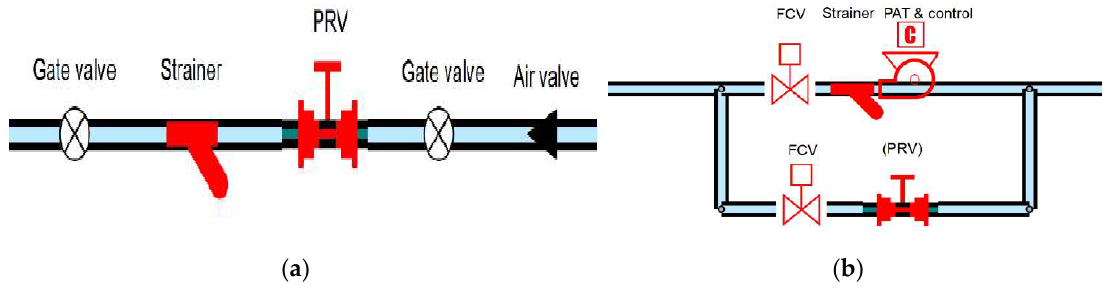
Figure 5. Installation scheme of a pressure reducing valve (PRV) ( a ) and a pump as turbine (PAT) ( b ).